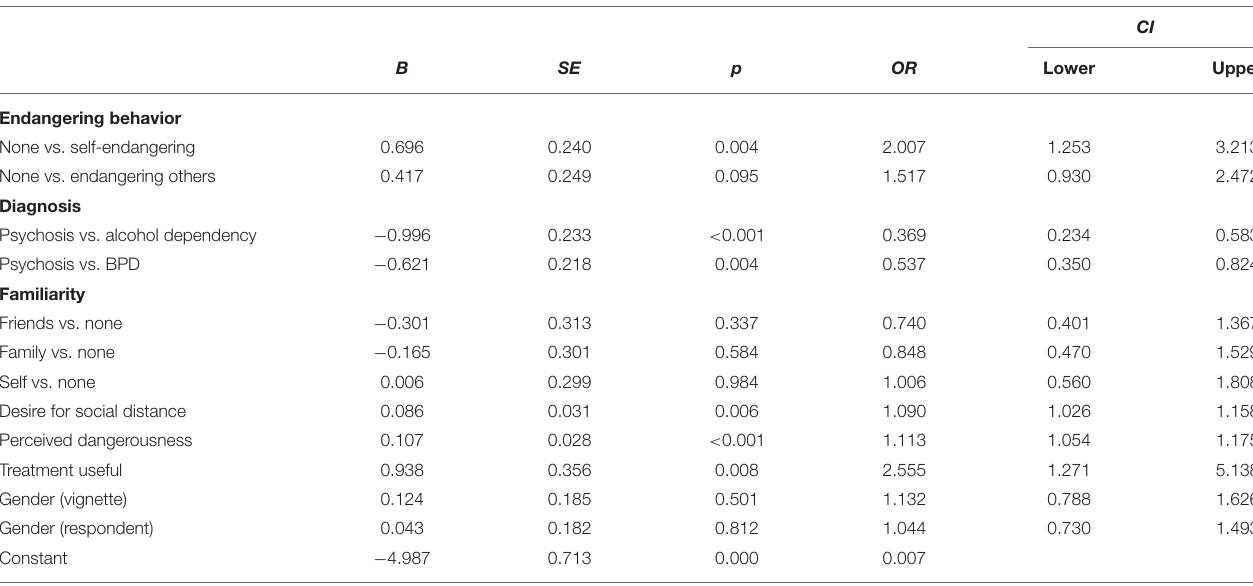
TABLE 4 | Logistic regression model for approval of involuntary